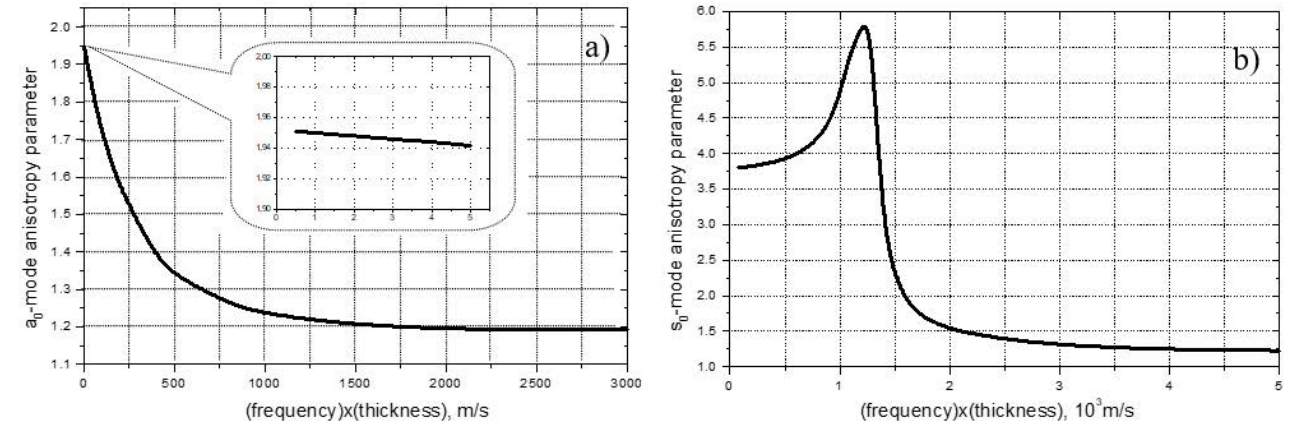
Figure 2. Calculations of dispersion parameters for in-plane anisotropy for a 0 - ( a ) and s 0 - ( b ) modes in